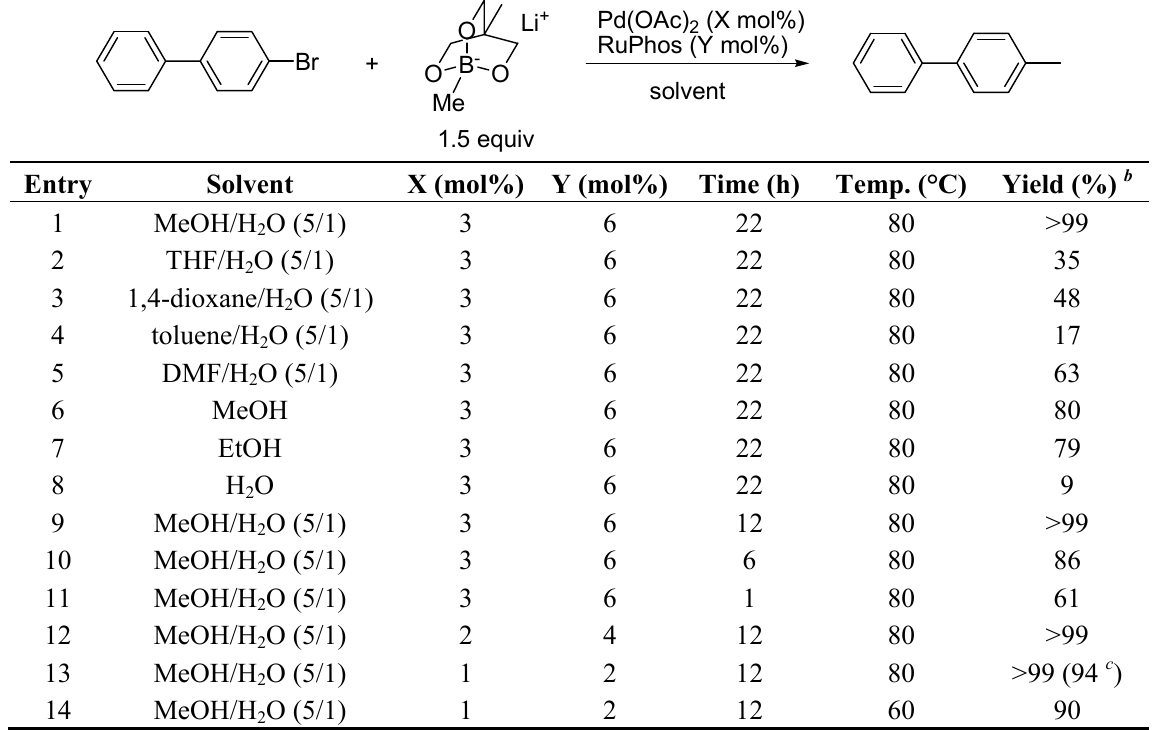
Table 2. Optimaization of methylation by lithium methyltriolborate a